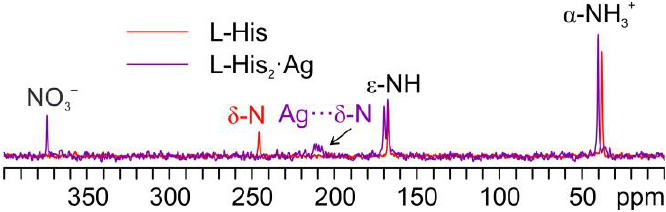
Figure 11. Overlay of a detail of the 15 N CPMAS spectra of L-His 2 ·Ag (in purple) and pure L-His (in red). (in